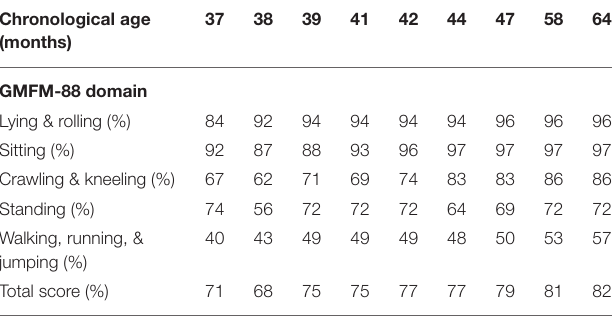
TABLE 1 | Gross motor function measure-88 from the treated patient.